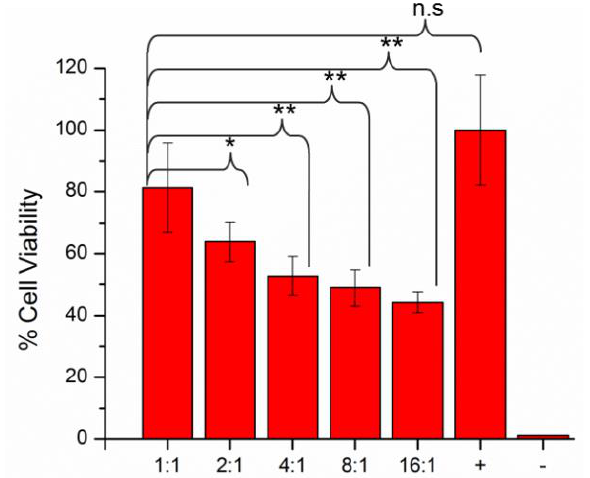
Figure 9. The effects of P(KA)/4-PEG hydrogel molar ratio on cell viability of NIH 3T3 cells are shown. The statistical significance is indicated by an asterisk (*) for p < 0.05 and double asterisks (**) for p < 0.01, as calculated from Student’s t -tests. The negative control group is represented by ( − ). The difference between the positive control group (+) and the 1:1 molar ratio group was not significant (n.s).